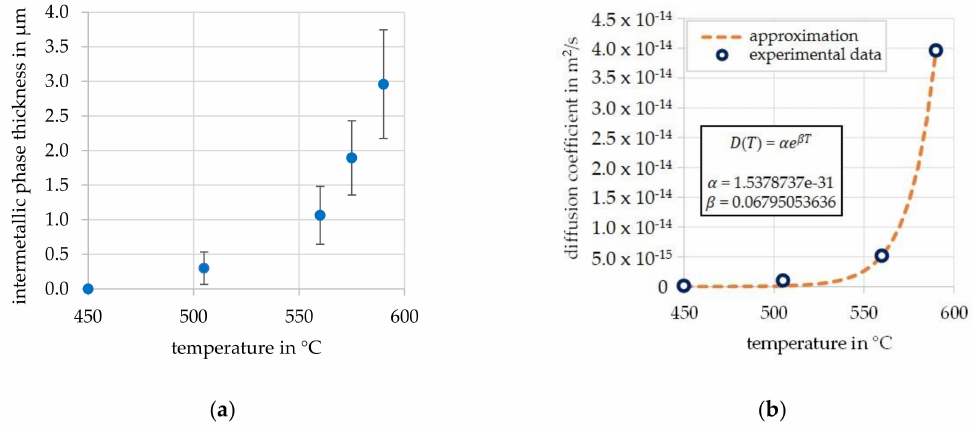
Figure 7. ( a ) Development of intermetallic phase seam thickness as a function of forming temperature with indication of the standard deviation for a forming time of 120 s and force of 5890 N, ( b ) apparent di ff usion coe ffi cient as a function of forming temperature with representation of the approximation